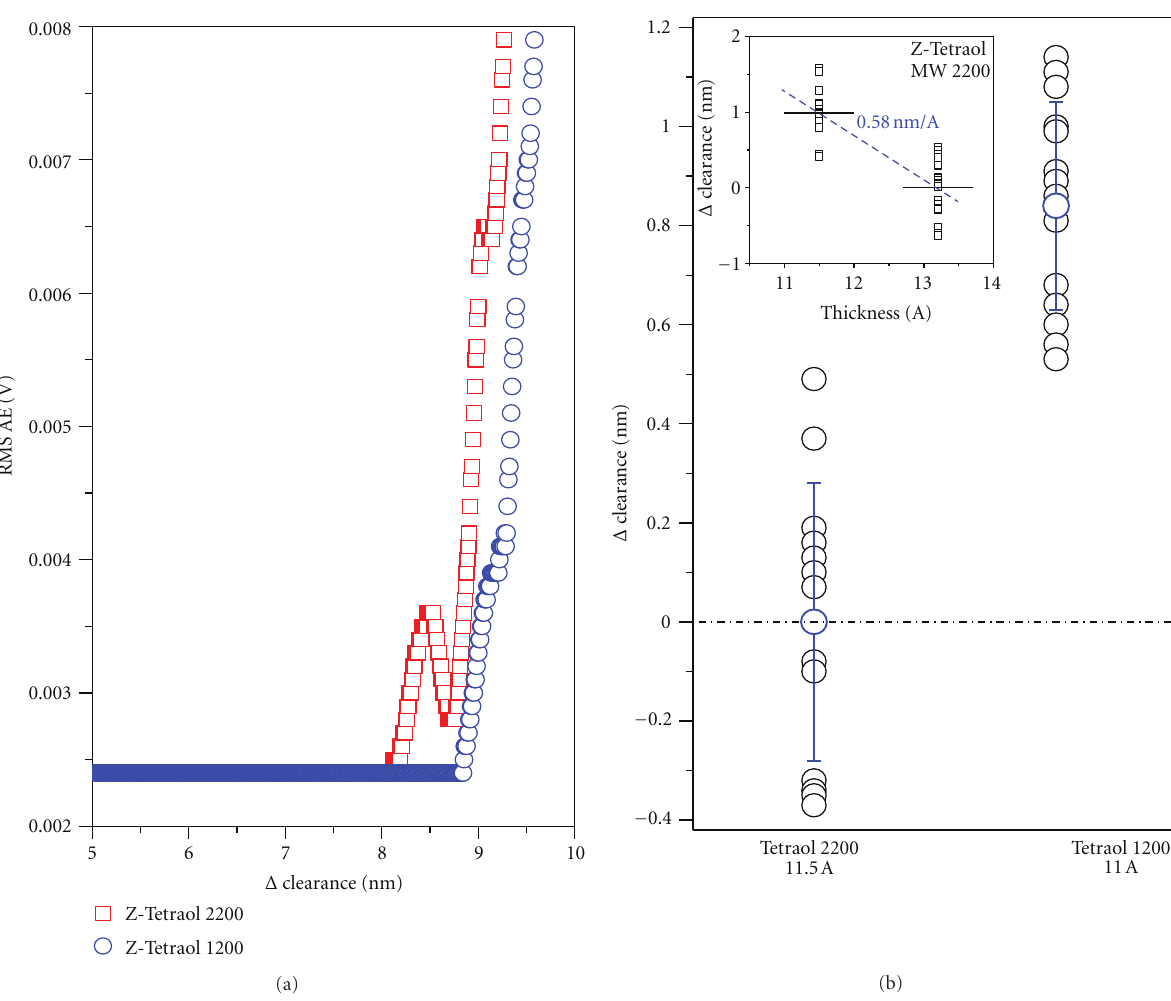
Figure 2: (a) Representative data plotting the rms acoustic emission (AE) as a function of slider-disk clearance for 11 . 5 ˚A Z-Tetraol 2200 and 11 . 0 ˚A Z-Tetraol 1200. The Δ clearance is defined as the distance between the thermally protruding read-write element of the slider and the disk surface. (b) The slider-disk clearance data plotted relative to Z-Tetraol 2200. Open circles are the individual data points. Average data are represented by the blue points with 1 sigma standard deviation. The inset figure plots the Δ clearance as a function of film thickness for Z-Tetraol 2200, providing a slope of 0 . 58nm / ˚A. Thus, approximately 0 . 3nm of the clearance di ff erence between 11 . 5 ˚A Z-Tetraol 2200 and 11 . 0 ˚A Z-Tetraol 1200 can be attributed to the thickness di ff